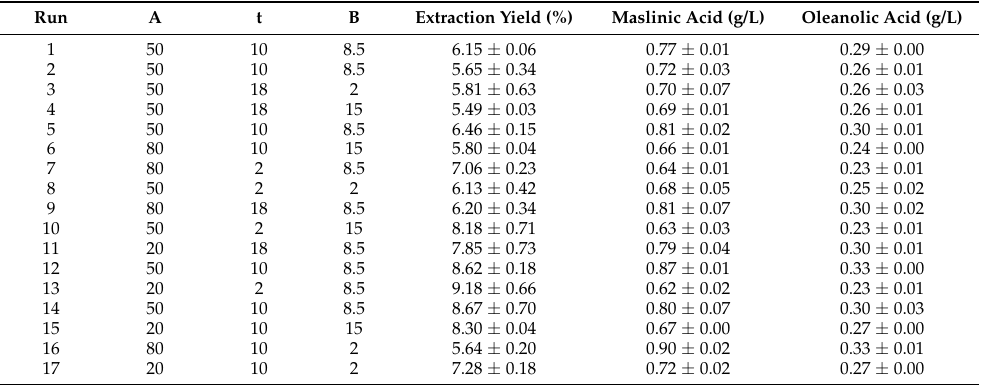
Table 6. Extraction yield and concentration of maslinic acid and oleanolic acid in the ethanolic extracts from each extracted solid of exhausted olive pomace obtained after the application of ultrasound-assisted water extraction in the Box–Behnken design.